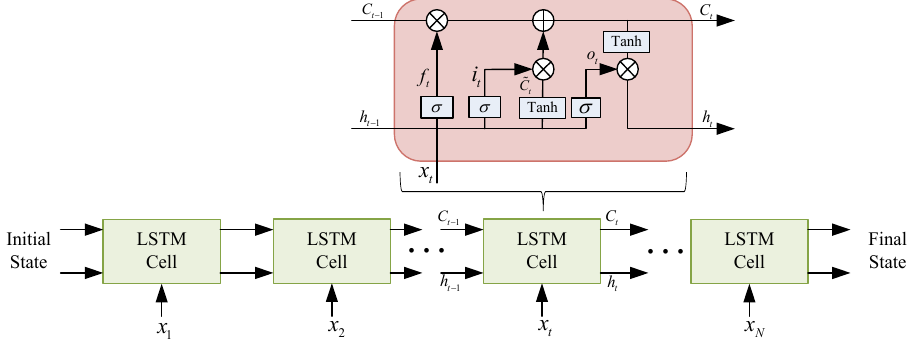
Figure 1. The structure of a standard LSTM network.